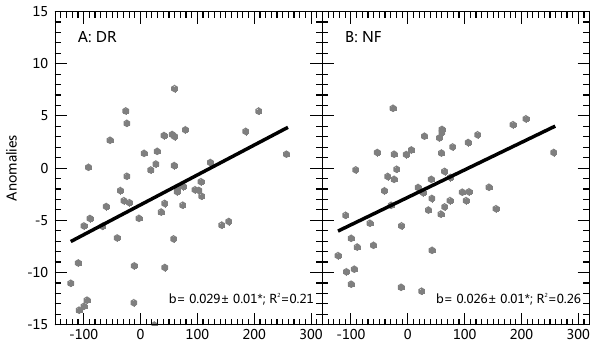
Figure 9. Relationship between anomalies of the freeze index of air temperature (AFI) and (a) duration (DR), and (b) number of days (NF) from 1956 through 2006 across China. All regression lines have a statistically significant trend with at least a 95% confi- dential